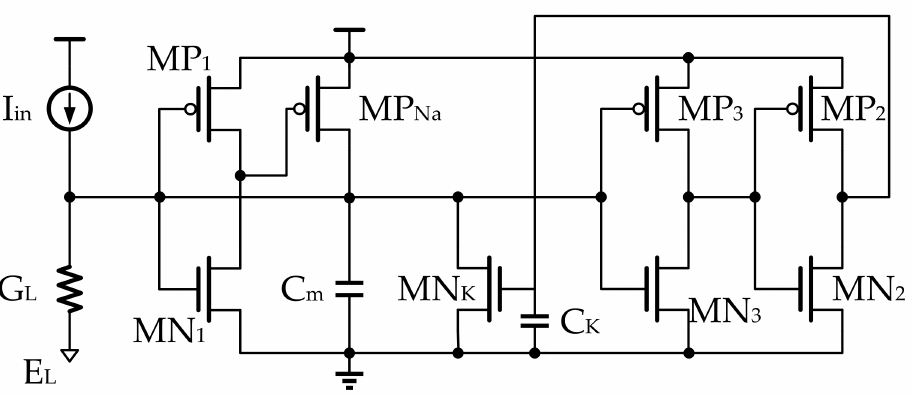
Figure 2. Artificial neuron circuits based on ML model. As drawn in [16].